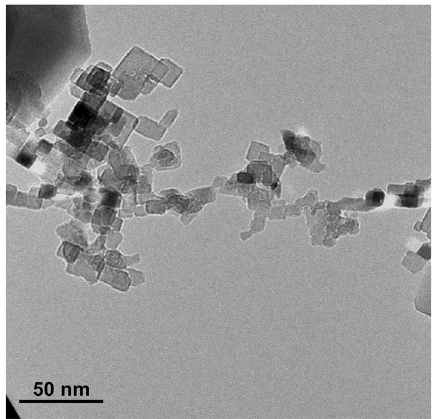
Figure 2. TEM showing the 10–15 nm size particles that appear only in the negative Mg flame.